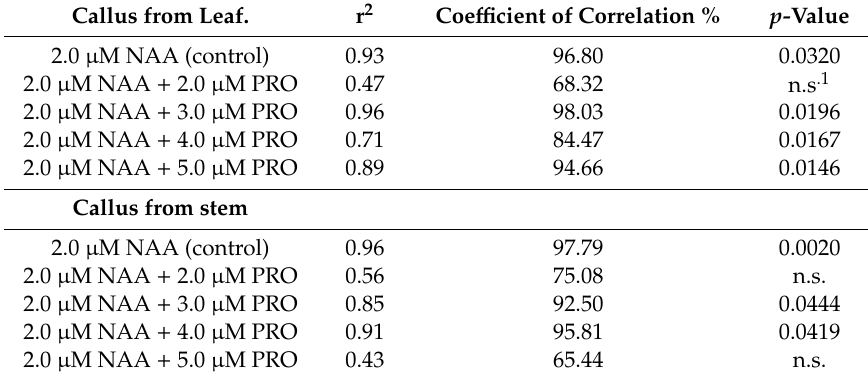
Table 4. Simple Pearson’s correlation of total phenolics with antioxidant activity in S. rebaudiana Bertoni cellular compounds of callus from leaf and stem explants in response to di ff erent concentrations of proline.